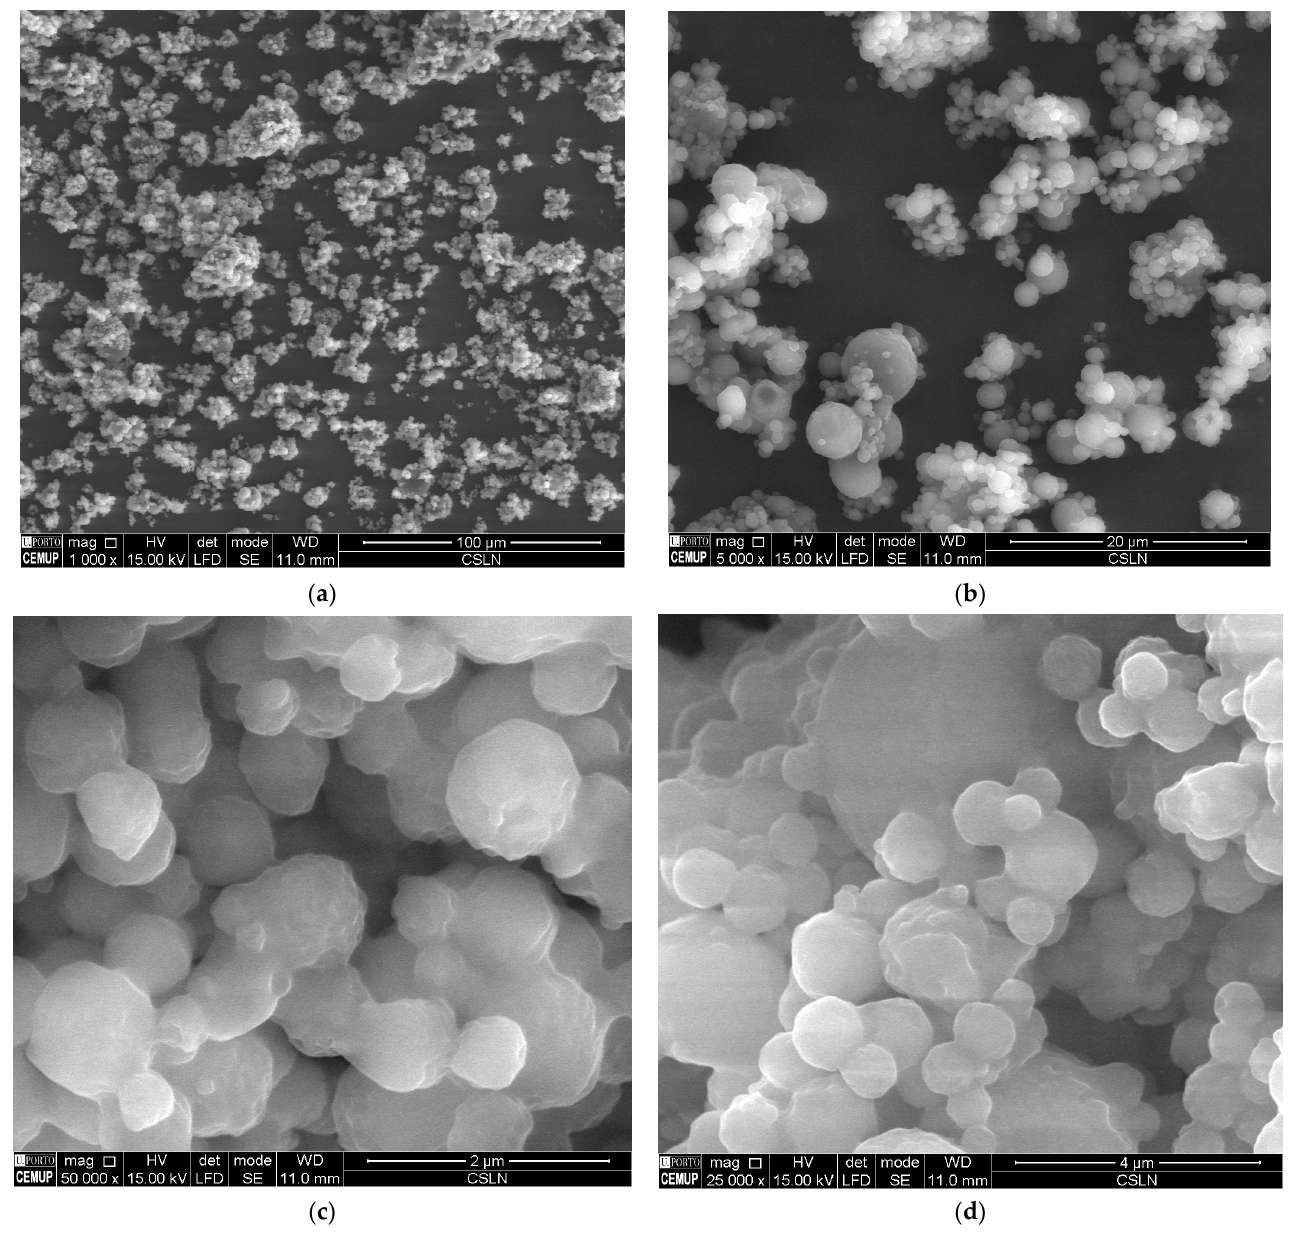
Figure 7. Scanning electron microscopy analysis of CBD-loaded cSLN at different resolutions, ( a ) 1000×, ( b ) 5000×, ( c ) 25,000×, and ( d ) 50,000×.